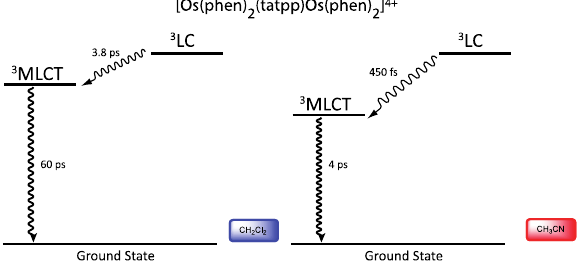
Figure 37. Energy level of the 3 MLCT and 3 LC states for the homodinuclear Os II -tatpp complex